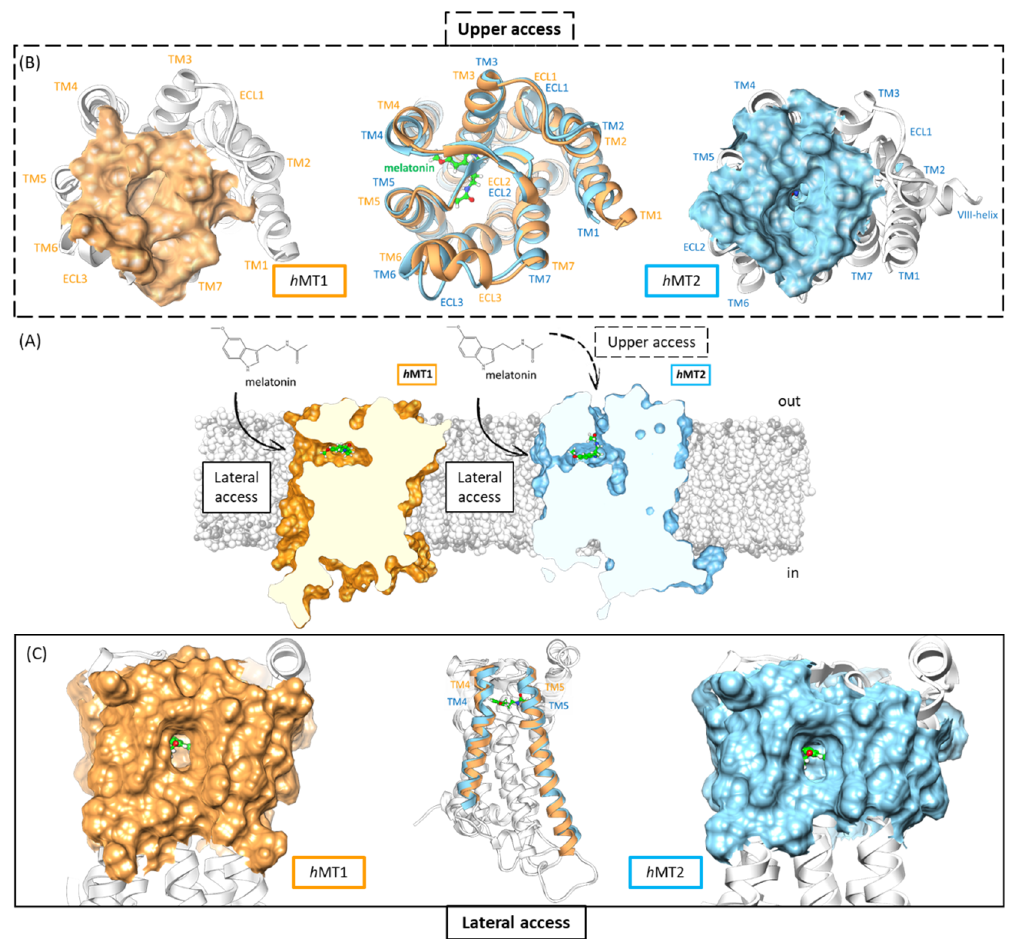
Figure 4. The h MT1 (orange) and h MT2 (light blue) structures. Melatonin is always in green. ( A ) depicts all potential ligand access routes for h MTs orthosteric sites. ( B ) represents a comparison between h MT's top-side paths. ( C ) shows the overall superimposition of both h MT1 and h MT2.